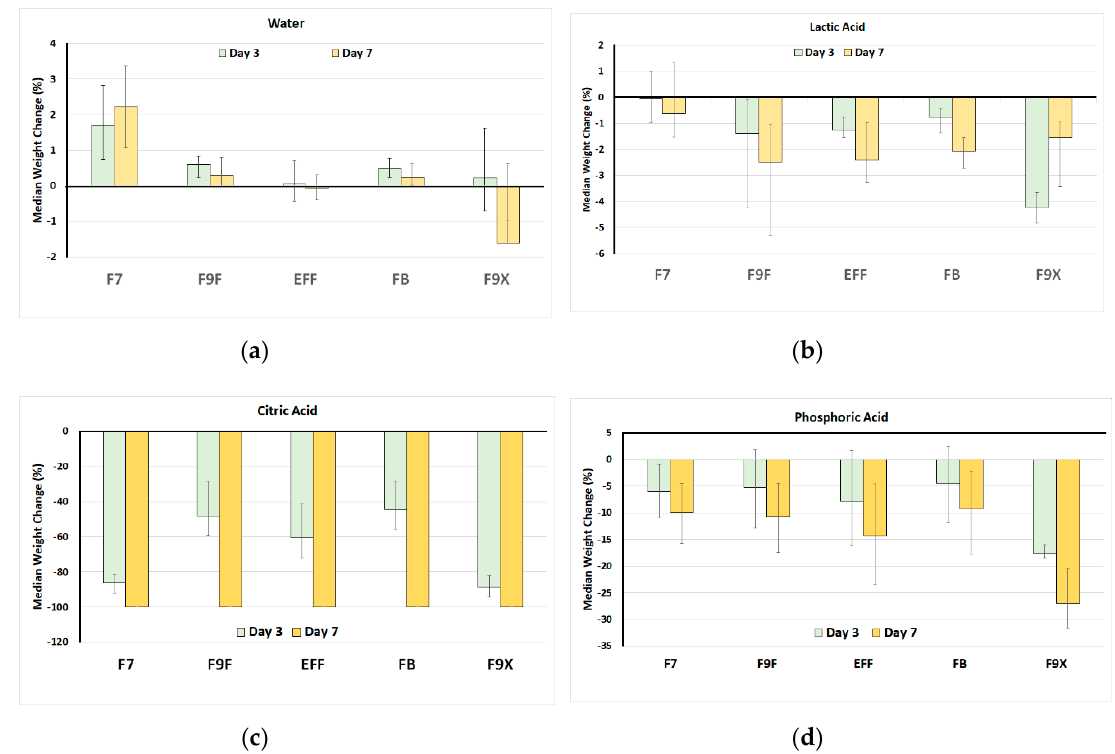
Figure 1. Median percent weight change of glass ionomer cements (GIC) discs after exposure to ( a ) water, ( b ) 0.1% lactic acid, ( c ) 10% citric acid, and ( d ) 0.2% phosphoric acid. In each series the sequence of GIC materials is GC Fuji ® VII (F7), GC Fuji ® IX Fast (F9F), GC Equia ® Forte Fil (EFF), GC Fuji ® Bulk (FB) and GC Fuji ® IX Extra (F9X). Error bars show 95% confidence intervals.